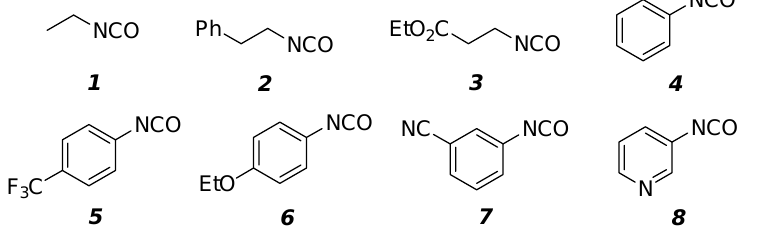
Figure 4. Isocyanates 13 { 1 – 8 } used for the reaction of scaffolds 6 { 1 – 6